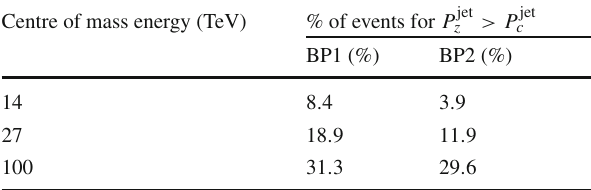
distributions as T